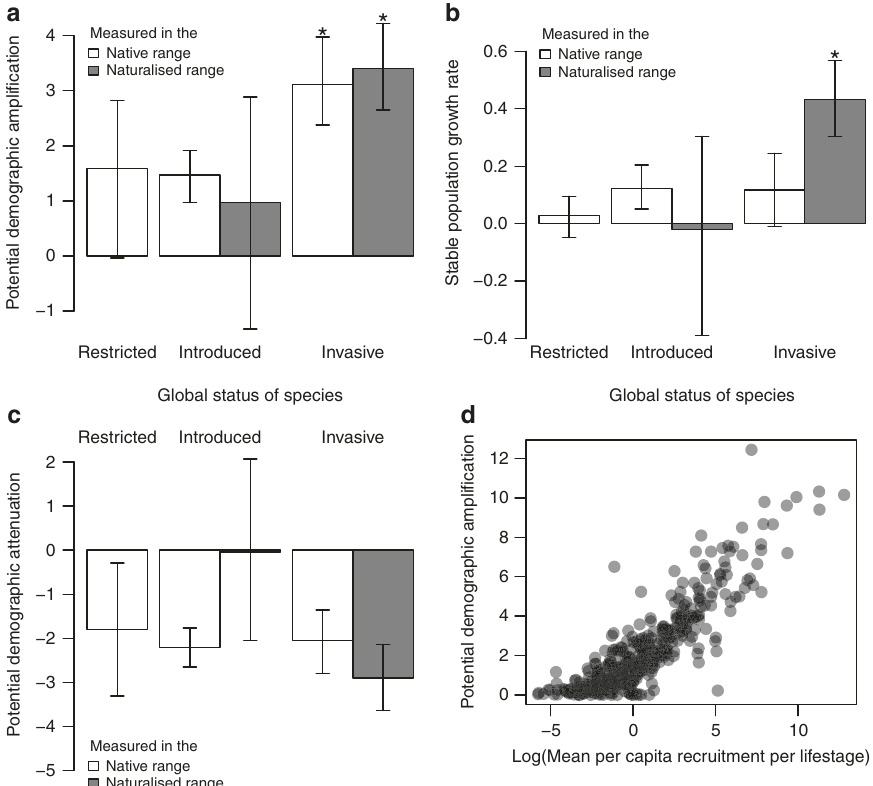
Fig. 2 Demographic traits of invasive and non-invasive plant species. Bars show mean demographic trait ( + / − 95% Credible Intervals) for restricted, introduced and invasive plants, measured in the respective native or naturalised range. Asterisks show invasive categories that are credibly different from all non-invasive categories, based on 95% credible intervals of contrasts between categories not overlapping zero; a potential for demographic recovery following disturbance (upper bound on demographic inertia; mean log( (cid:1) ρ 1 )); b stable rate of population increase (mean log ( λ )); and c potential for reduced abundance following demographic disturbance (lower bound on demographic inertia; mean log( ρ ∞ )). d Relationship between potential demographic recovery (mean log( (cid:1) ρ 1 )) and rates of offspring recruitment (log(mean recruitment per lifestage)). Dark areas are caused by overlapping data. Source data are provided as a Source Data fi